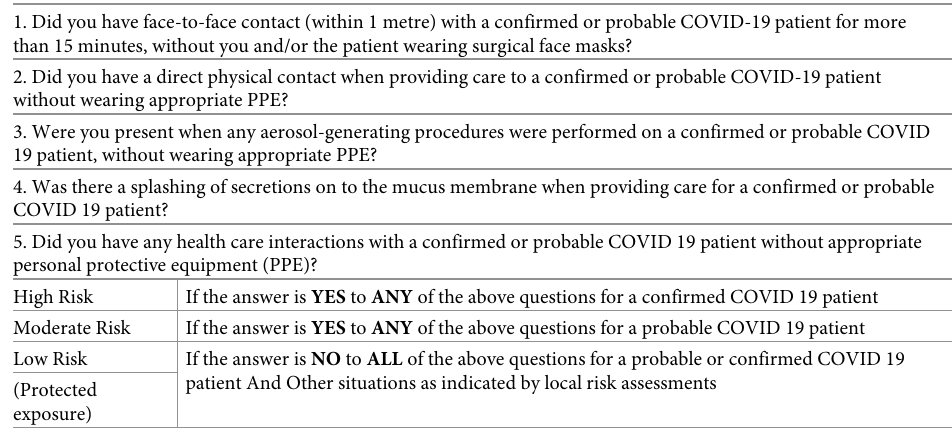
Table 1. 5-questions based risk assessment